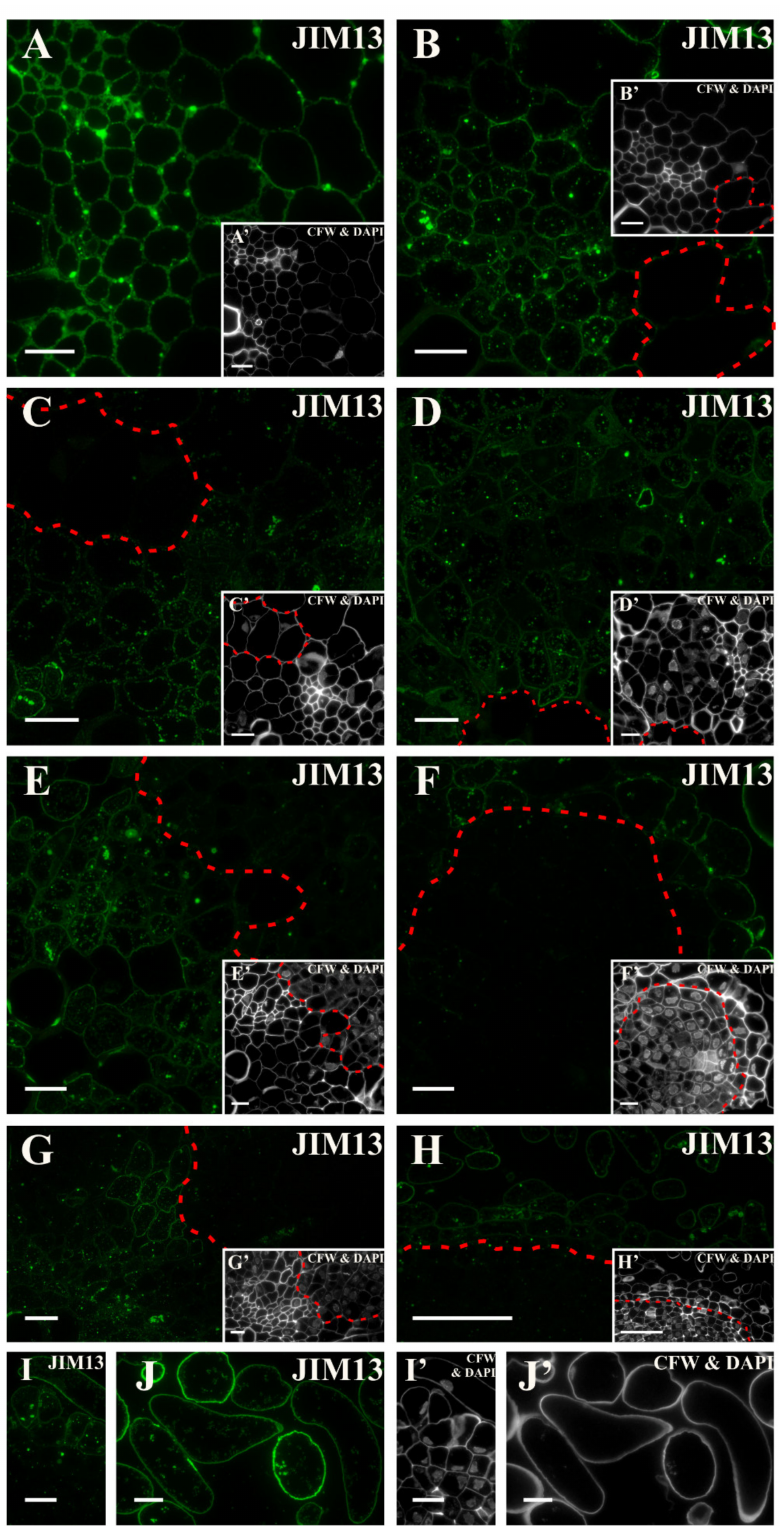
Figure 8. Distribution of the AGP epitope that is detected by the JIM13 antibody. ( A ) At the beginning of the culture, a clear signal in the cell walls of all of the explant tissues was observed. ( B ) After one day of the culture, signal was detected in the cell walls as well as in the cytoplasmic compartments of all of the cells except the pericycle cells that were located on the xylem pole (area marked with a dashed